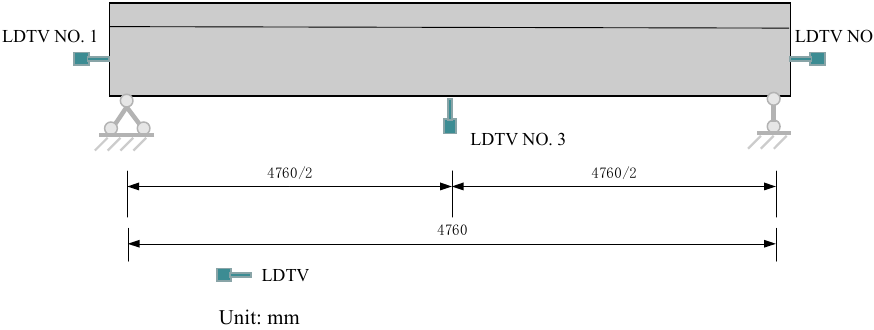
Figure 3. Layout of the displacement measuring points.